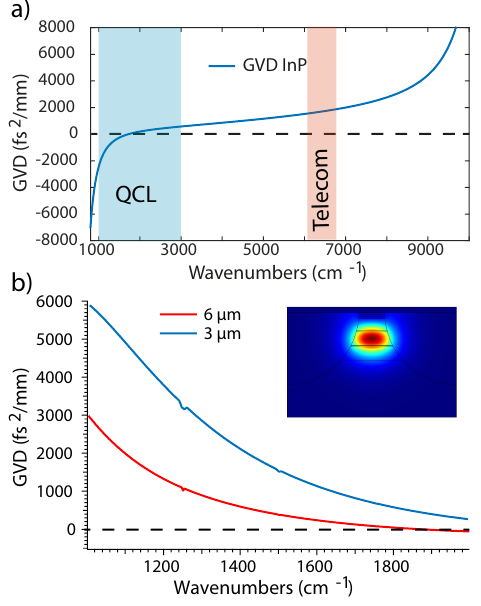
Figure 5: Contributions to the waveguide dispersion. a GVD for bulk InP material. b GVD due to the mode confinement, computed by performing a two-dimensional simulation, computed for two dif- ferent ridge widths, as indicated. Inset: mode profile of a typical mid-infrared QCL.